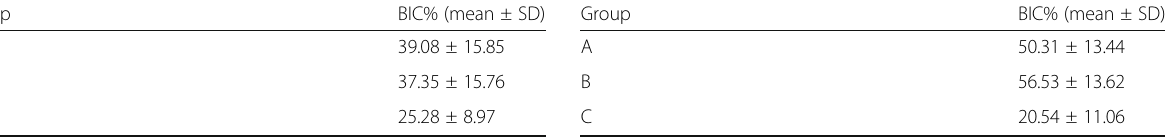
Table 2 Mean BIC% value of each group after 15 days of healing Group